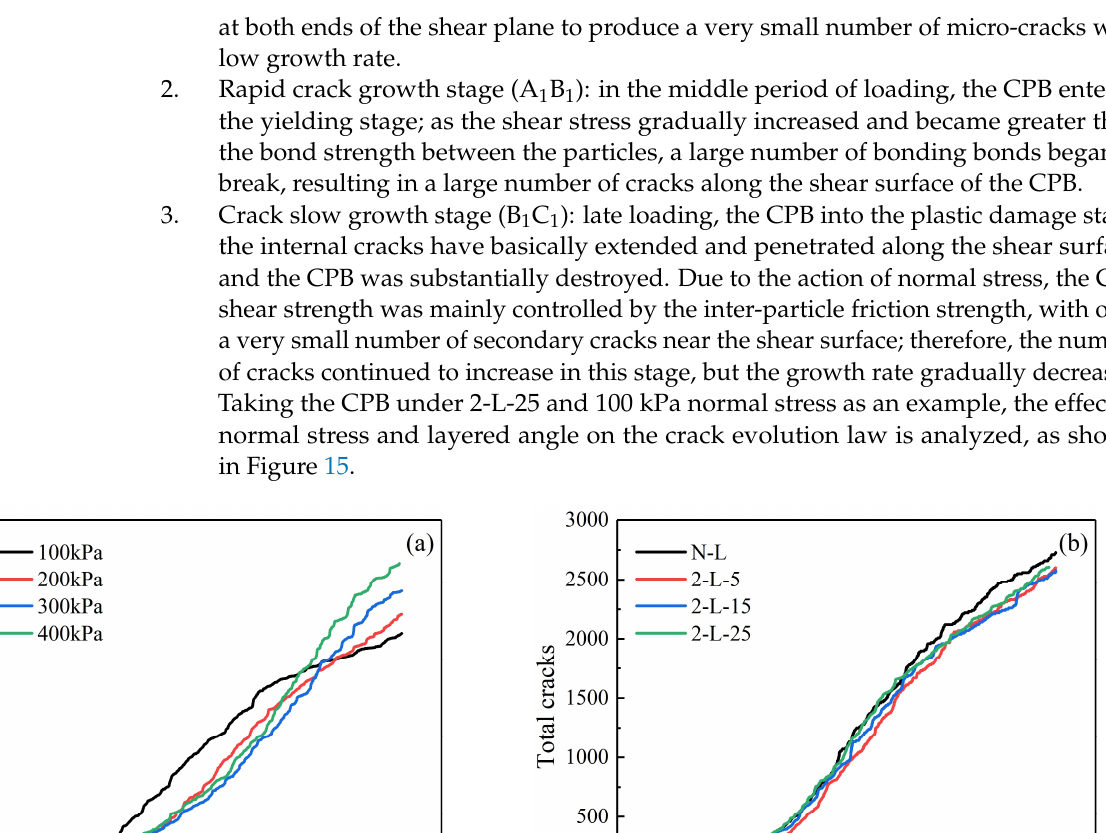
Figure 15. Total number of micro-cracks: ( a ) 2-L-25; ( b ) 100 kPa normal stress.